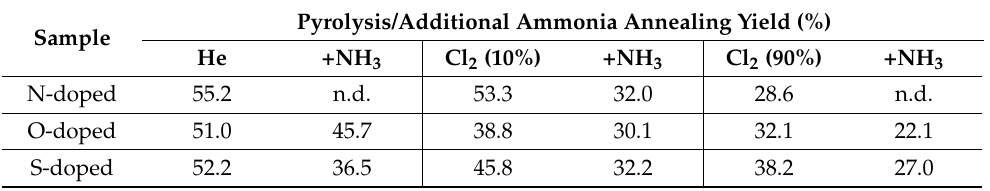
Table 2. Total yields of pyrolysis and additional ammonia annealing of the performed treatments.